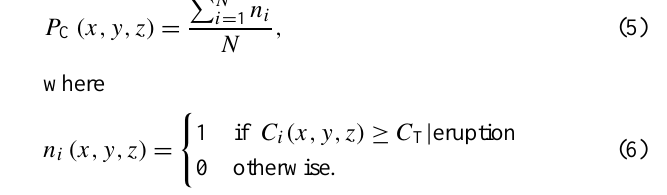
Table 2. Historical eruptions at Katla that produced tephra vol- umes > 0 . 1km 3 (Thordarson and Larsen, 2007). Uncompacted vol- umes are presented either as moderate ( > 0 . 1–0.5km 3 ) or large ( > 0 . 5km 3